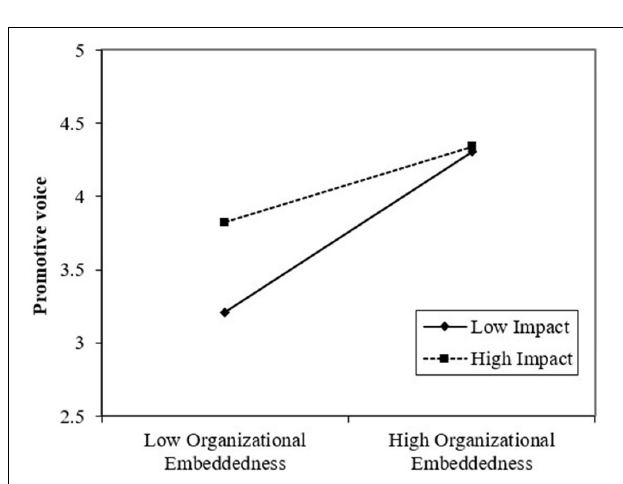
FIGURE 3 | The moderating role of sense of impact for the relationship between organizational embeddedness and promotive voice.